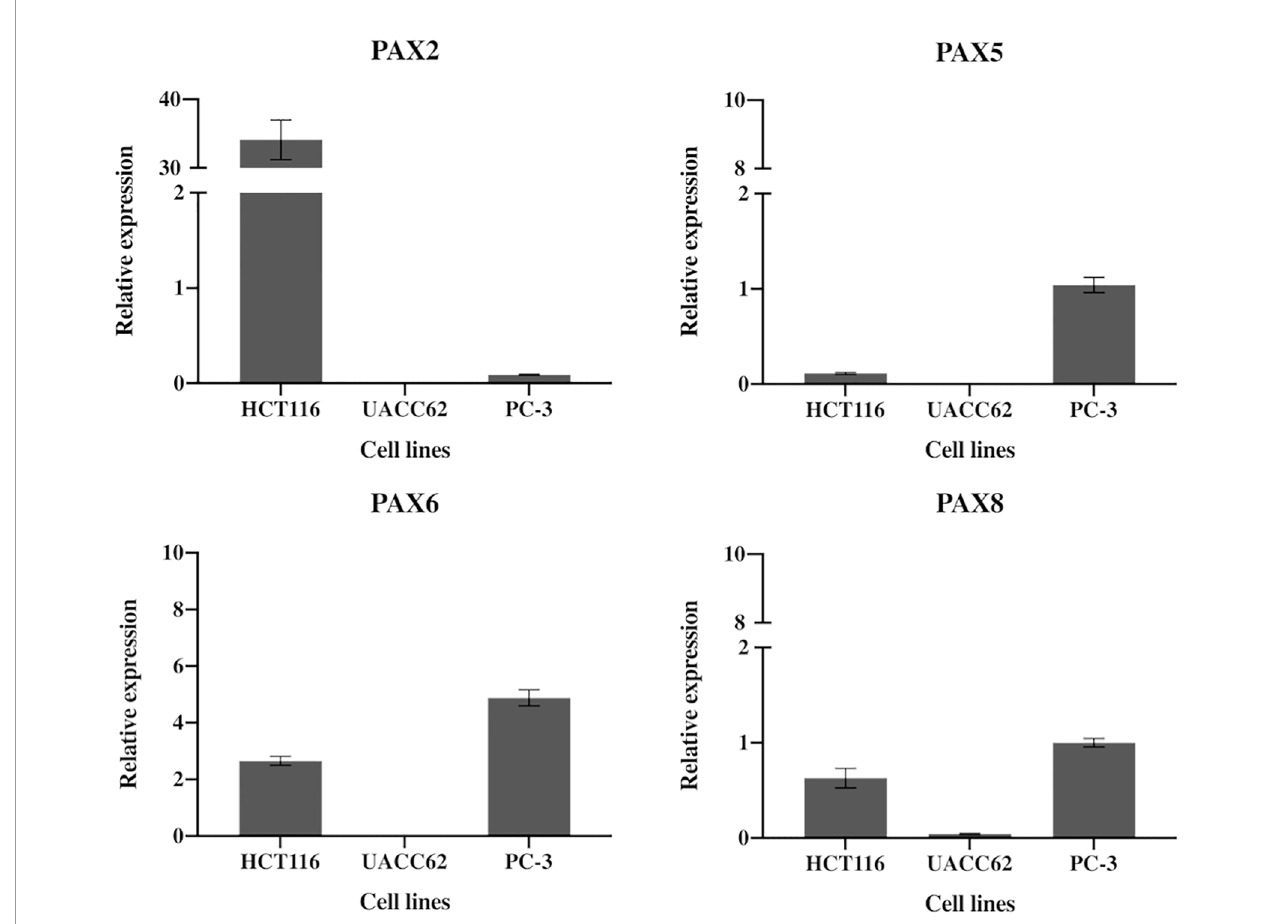
FIGURE 4 | Expression of PAX2, PAX5, PAX5 and PAX8 genes in HCT116 cells. HCT116 and two additional cell lines (MCF10A and PC-3) show differential expression of the PAX genes likely to be inhibited by EG1. The HCT116 cells express PAX2 34-fold and PAX6 2.7-fold more than the housekeepers (B2M, HPRT1 and UBC). HCT116 also express both PAX5 (0.1) and PAX8 (0.6) although both were detected at very low levels